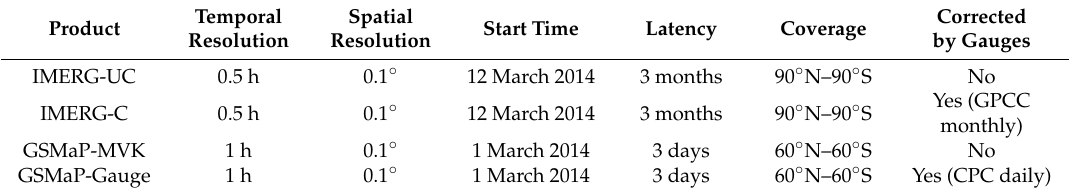
Table 1. Coverage and spatiotemporal resolutions of satellite precipitation products used in this